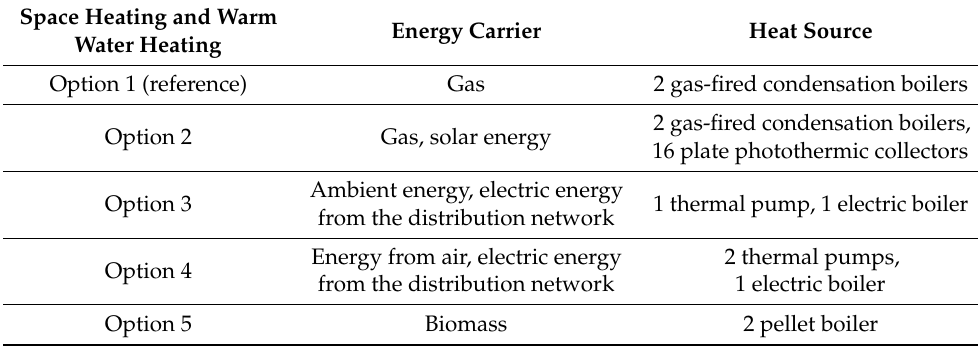
Table 7. Description of